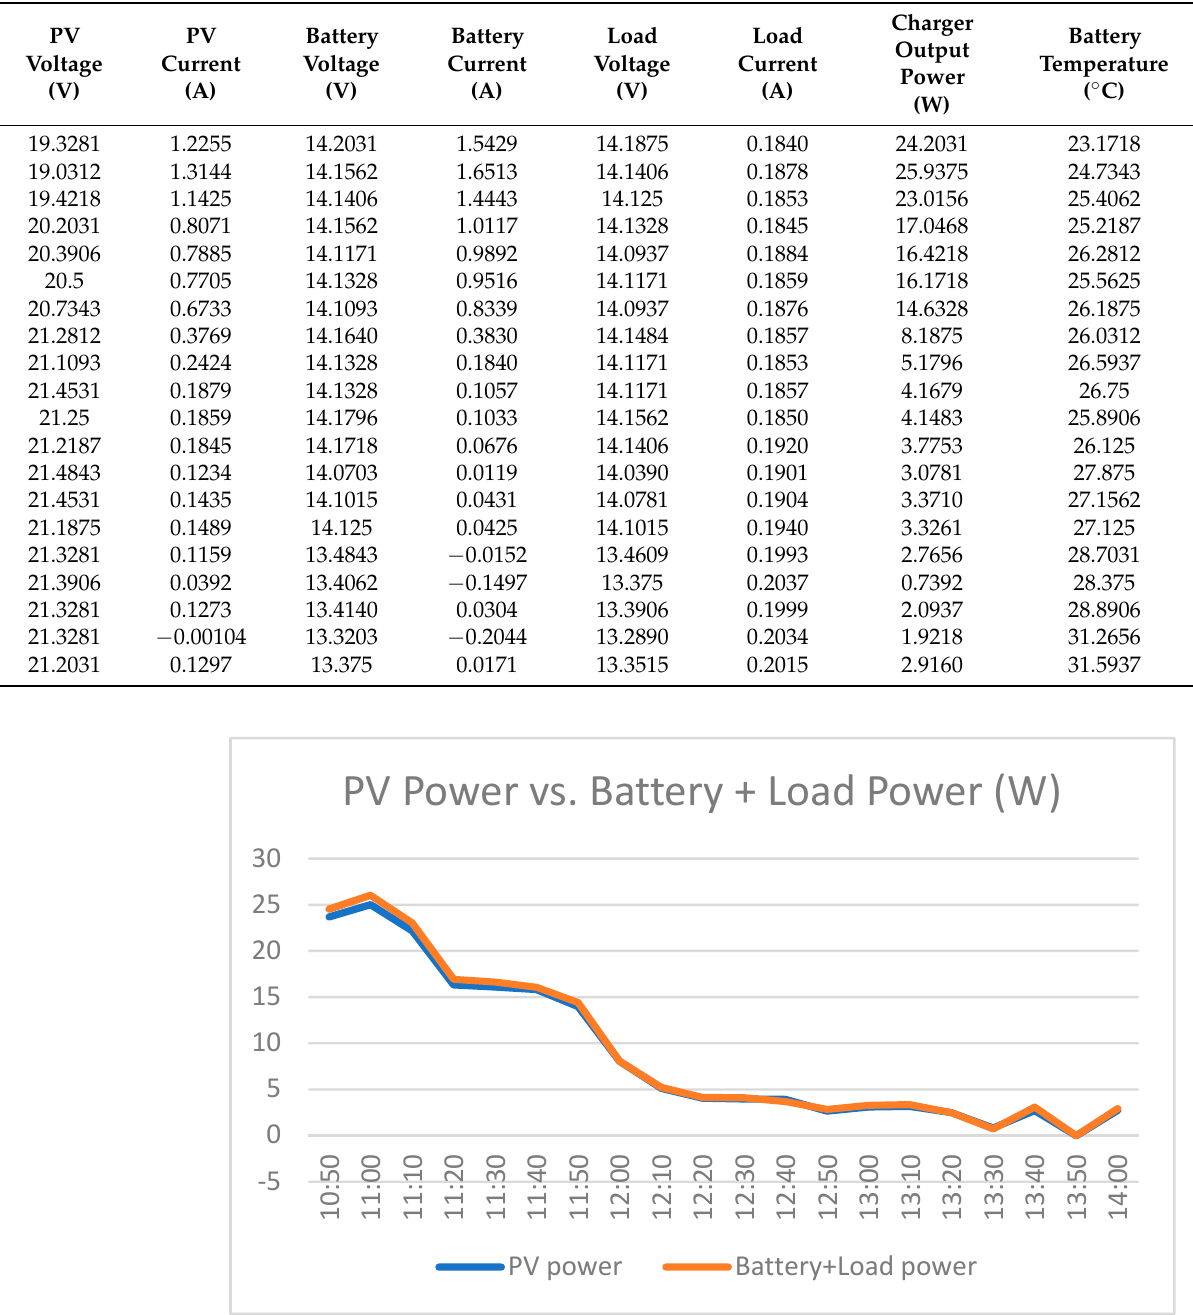
Figure 8. PV Output Power Equal to Sum of Battery and Load Power.